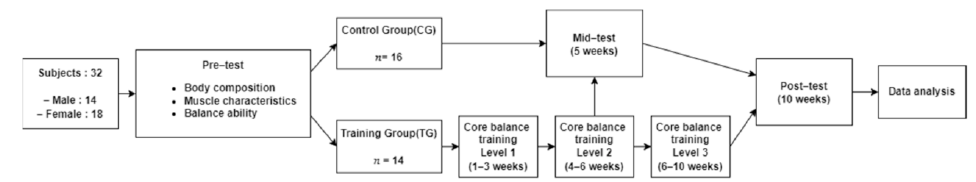
Figure 1. Research design.